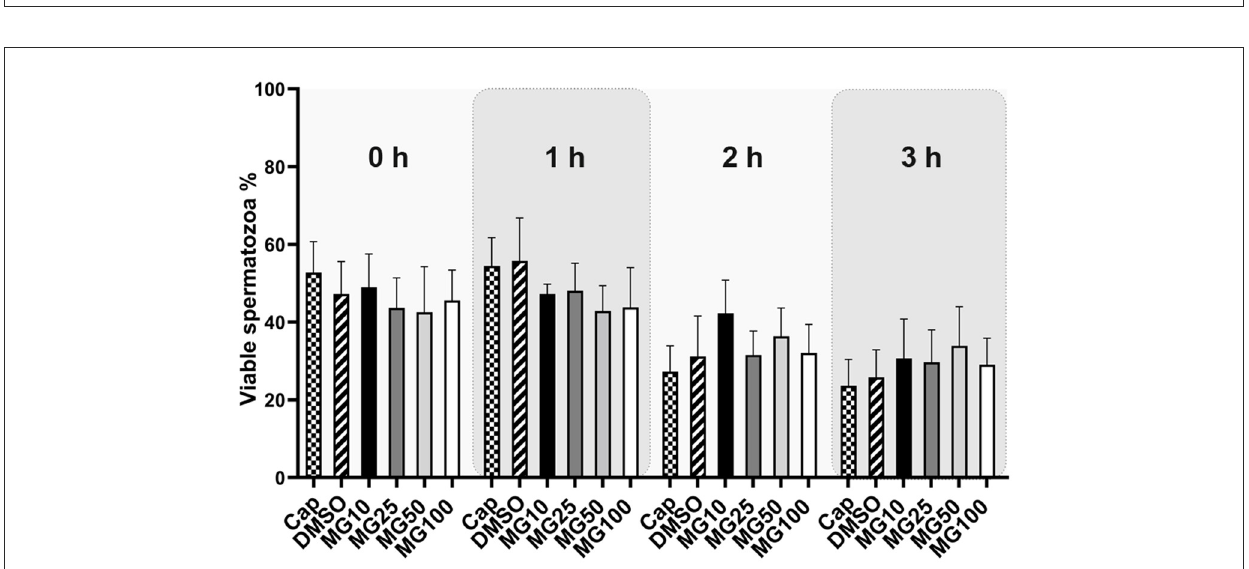
FIGURE4 Sperm viability assessment during 3h of in vitro capacitation (IVC) under proteasomal inhibition by MG-132 of various concentrations (10, 25, 50, and 100 µ M). Control treatment groups comprised IVC spermatozoa incubated (i) without both the inhibitor and vehicle (Cap) and (ii) without the inhibitor and with the vehicle (DMSO). Data are presented as mean ± SEM. No significant differences were observed; n = 20.